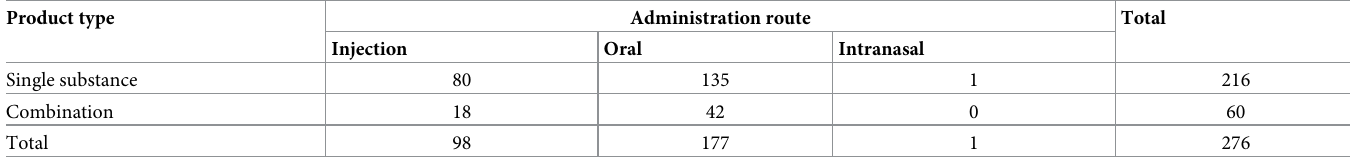
Table 1. Distribution of antimicrobial products approved for use in pigs in Japan by administration route and number of active ingredient contained. Product type